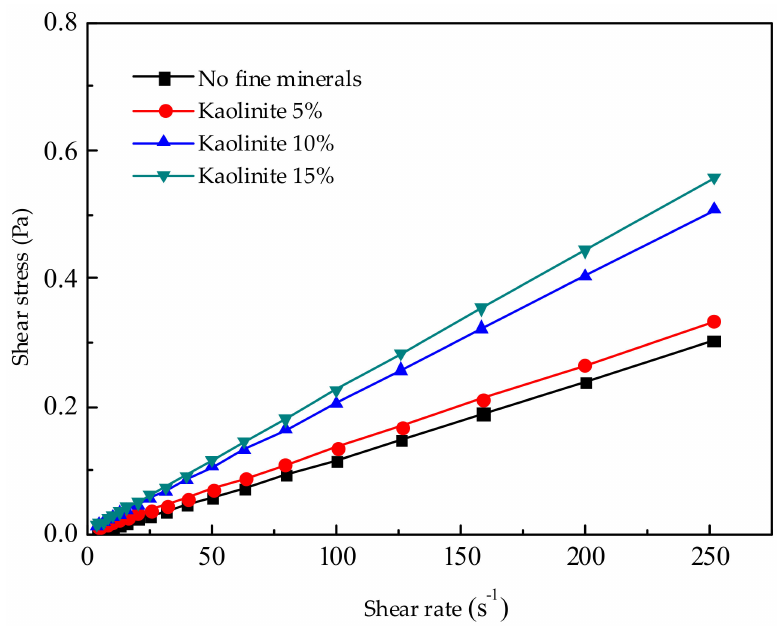
Figure 5. E ff ect of di ff erent kaolinite additions on pulp